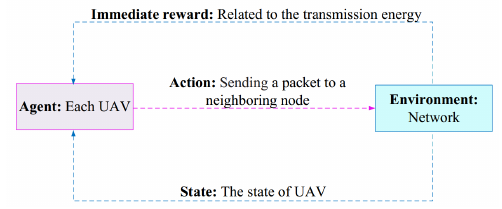
Figure 33. Learning process in FEQ-routing-SA. Table 15. The most important advantages and disadvantages of